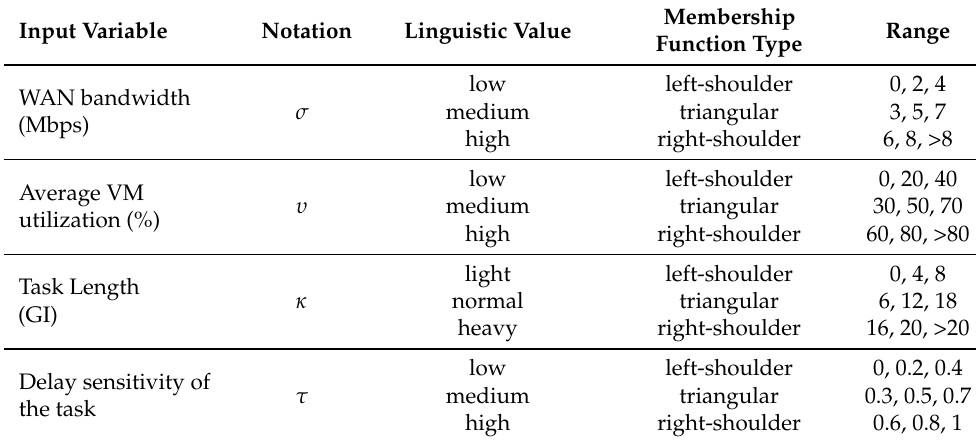
Table 3. Related parameters in the fuzzification of the second